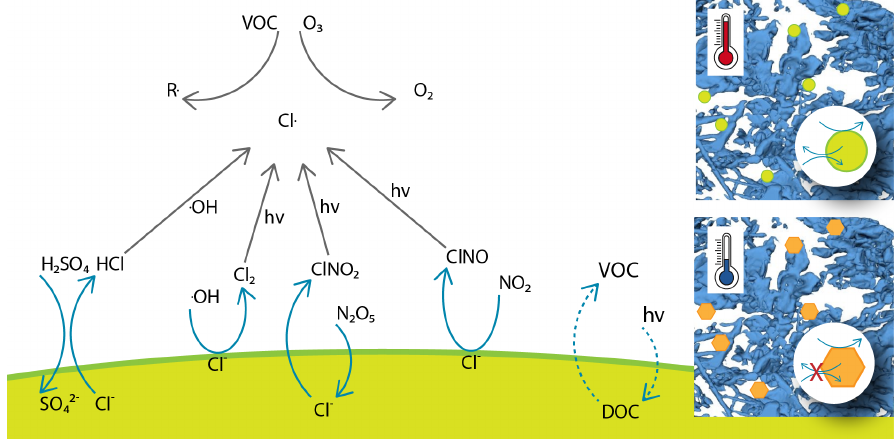
Figure 1. Simplified scheme of multiphase reactions liberating chlorine from sea-salt deposits to the atmosphere and subsequent reactions of chlorine with impacts on the ozone budget and air quality. These reactions may occur both in the bulk phase and at the air–deposit interface for liquid particles. The sea salt may also maintain a liquid phase for the reaction of other reactants such as the photolysis of organics. The inserts illustrate sea-salt deposits in snow and how phase changes from solid (orange hexagon) to aqueous solutions (green circle) impact the chemical reactivity. See text for details and